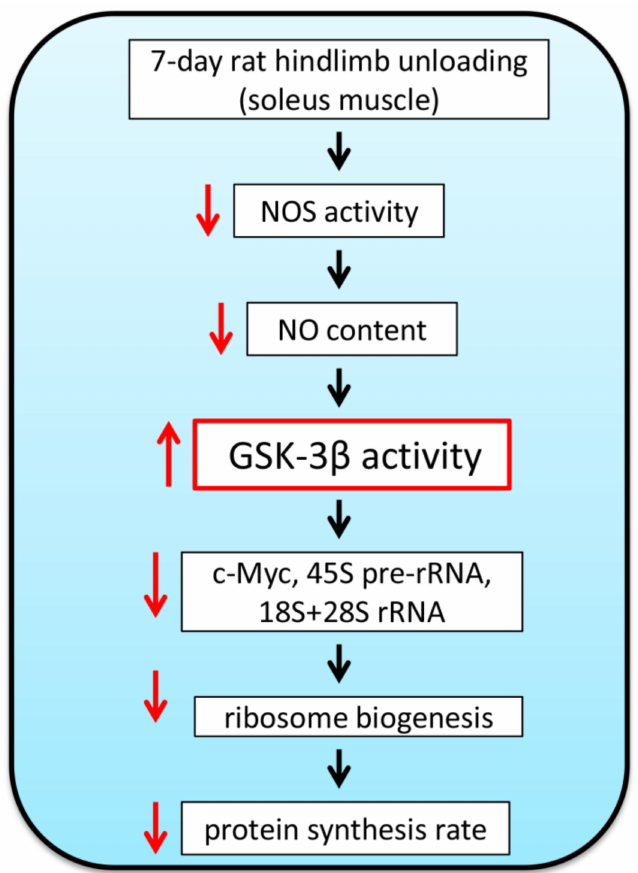
Figure 3. Simplified diagram showing the role of NO-dependent regulation of ribosome biogenesis via modulation of GSK-3 β activity in rat soleus muscle under disuse conditions. One-week hindlimb unloading results in a significant reduction in NO content in rat soleus muscle. This event leads to a significant increase in GSK-3 β activity (a decrease in GSK-3 β Ser9 phosphorylation) which, in turn, can negatively affect ribosome biogenesis and the rate of muscle protein synthesis. Upwards red arrow indicates upregulation; downwards red arrows indicate downregulation. NOS—nitric oxide synthase, NO—nitric oxide, c-Myc—c-myelocytomatosis oncogene (transcription factor), rRNA— ribosomal